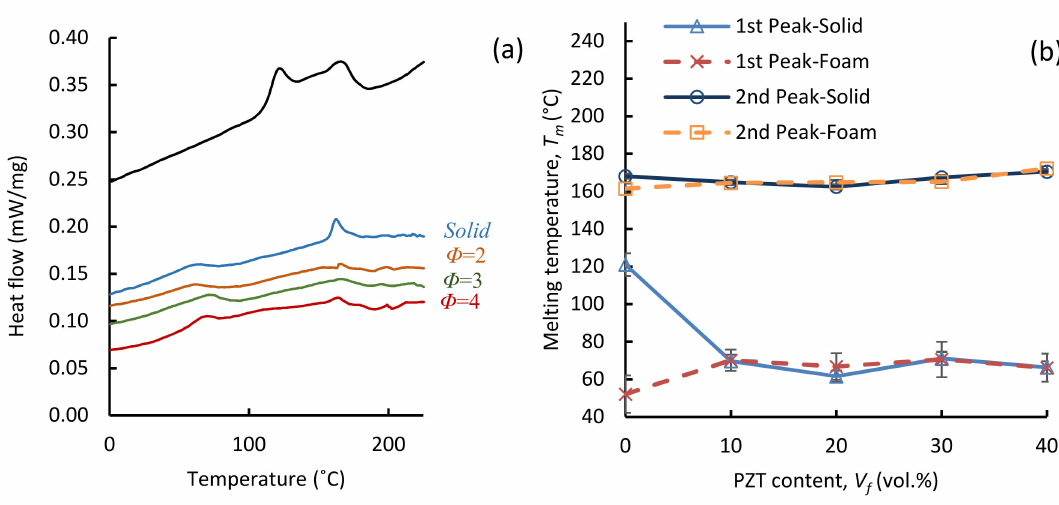
Figure 4. ( a ) Differential scanning calorimetry (DSC) heating thermographs of neat TPU and solid and foamed TPU/20 vol % PZT samples and ( b ) variation of the low and high melting peaks ( T mlow and T mhigh ) of solid and foamed ( ϕ = 2) composites as a function of PZT